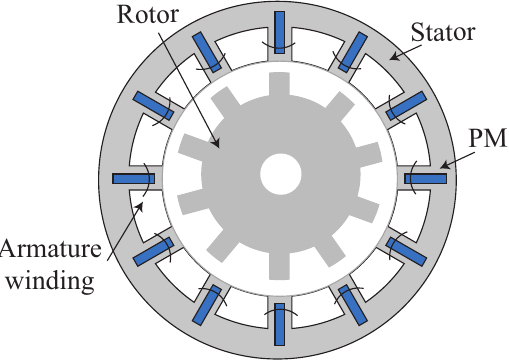
Figure 5. Flux-switching